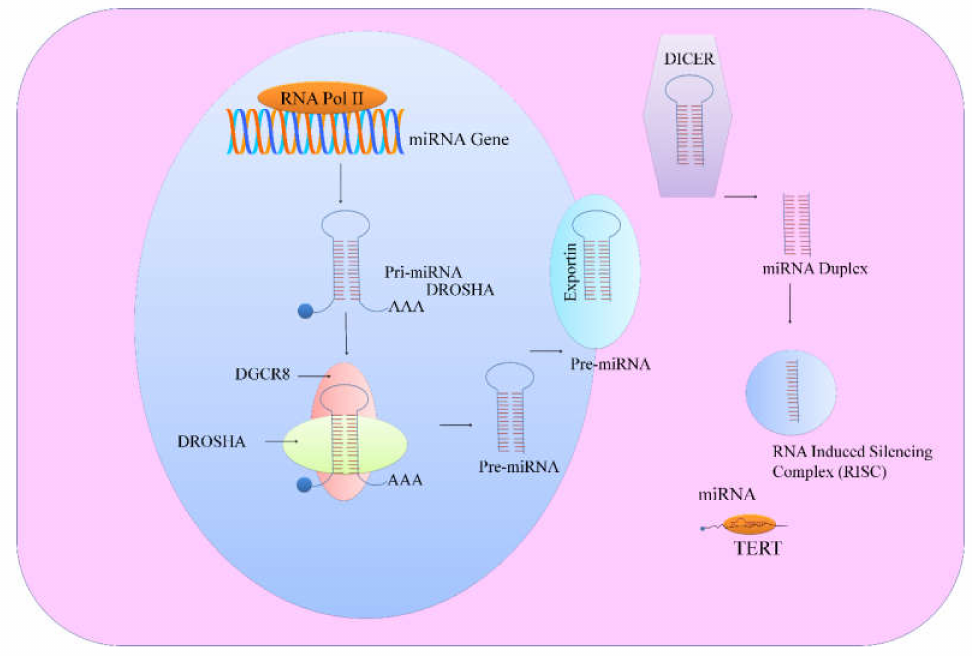
Figure 1. Schematically represents miRNA biogenesis and different steps involved in its maturation. DICER, one RNase III enzyme; DROSHA, another RNase III enzyme; TERT, telomerase reverse transcriptase.